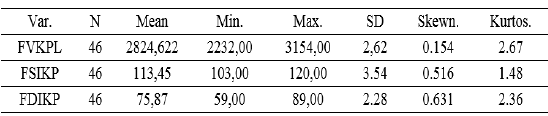
Table 1. Basic statistical parameters for the evaluation of functional abilities